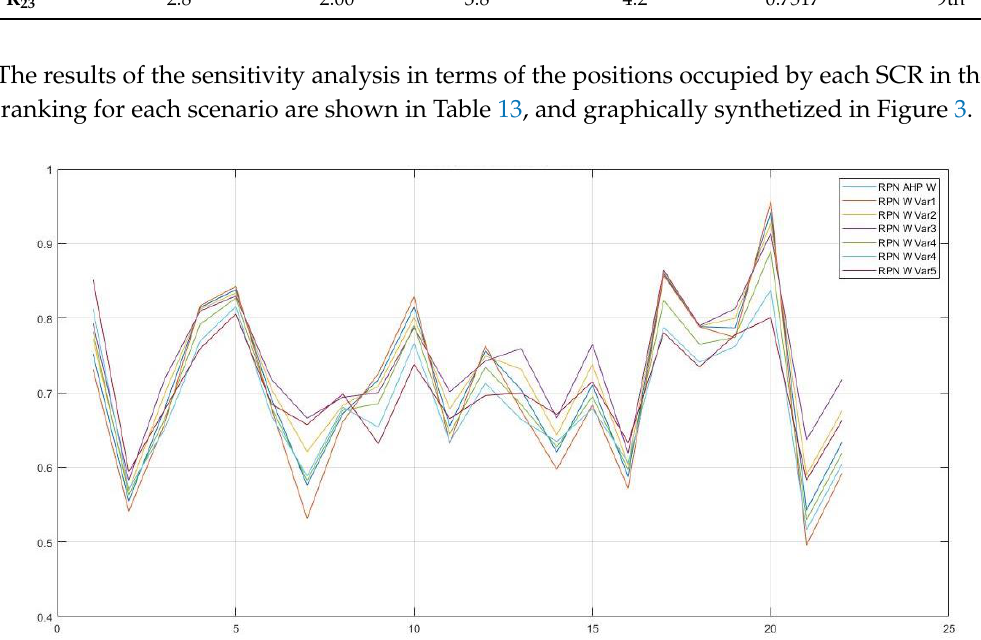
Figure 3. Sensitivity analysis for the RPN values in various scenarios regarding the factors’ weights.